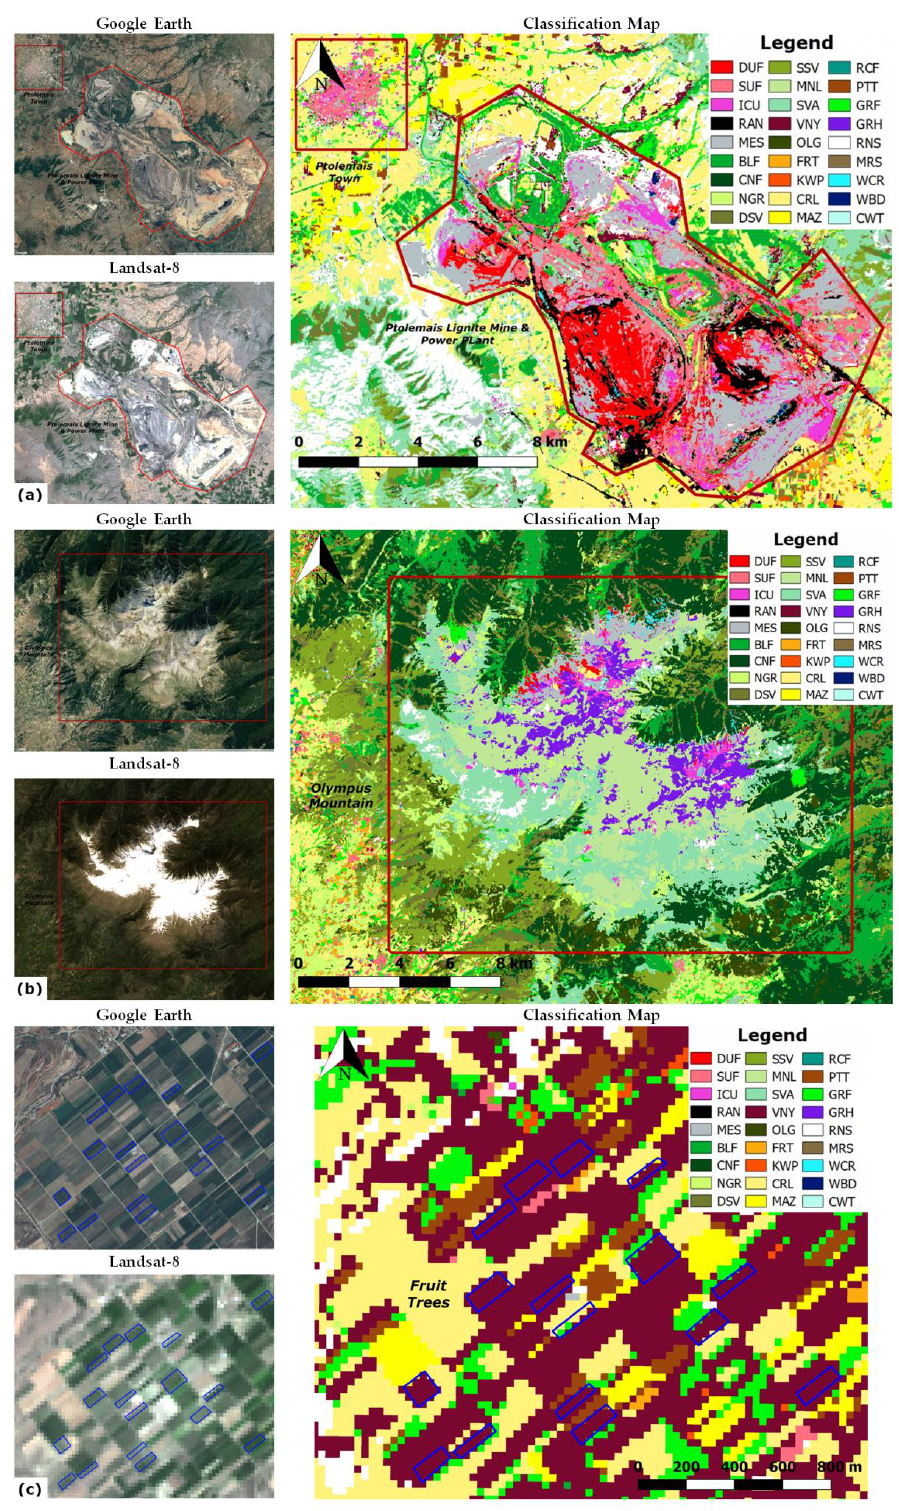
Figure 9. Indicative cases with classification errors regarding: ( a ) the MES land cover class, ( b ) the MNL, SVA and RNS classes and ( c ) parcels of the FRT class (outlined with blue).